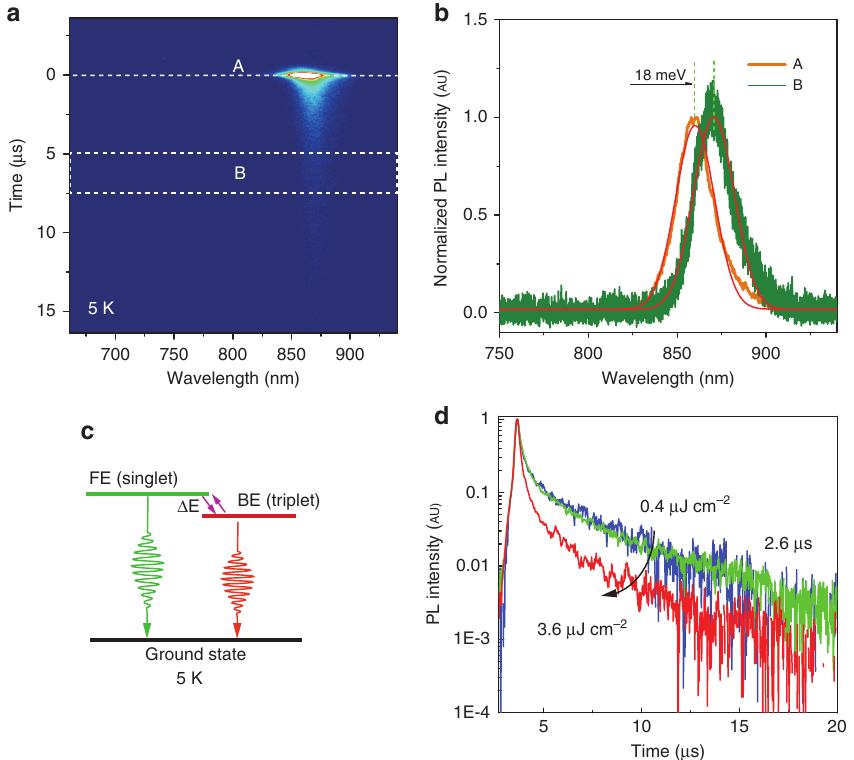
Figure 5 ( a ) Streak camera data showing the time-resolved PL emission at 5 K. ( b ) PL spectra (with Gaussian fi t) taken at different time delays after excitation. A is the PL spectrum at time = 0; B is the PL spectrum taken from 5 to 7.5 μ s. ( c ) Proposed energy level diagram for FAPbI3 perovskite at 5 K, involving a FE and a BE. ( d ) Power dependence of the time-resolved PL curve. BE, bound exciton; FAPbI 3 , formamidinium lead iodide; FE, free exciton; PL, photoluminescence.